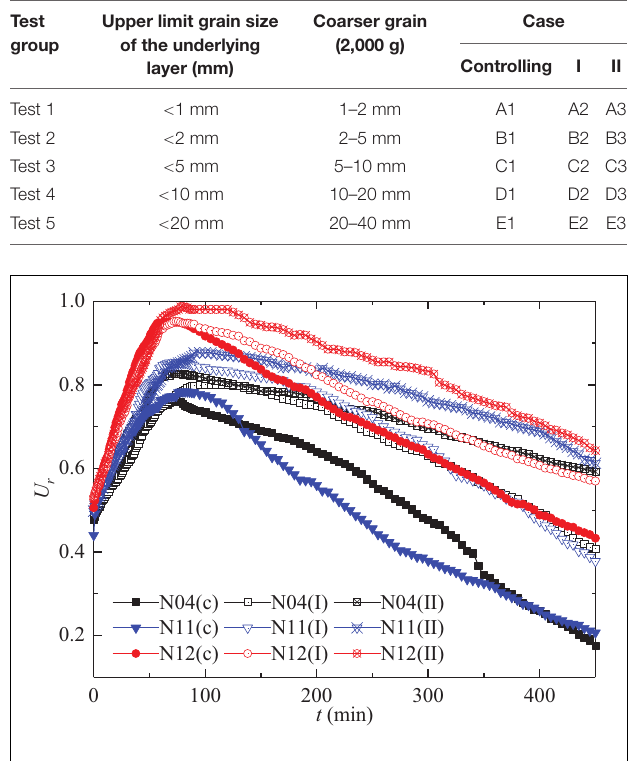
FIGURE 7 | Temporal variation of relative excess pore pressure ( Ur ).